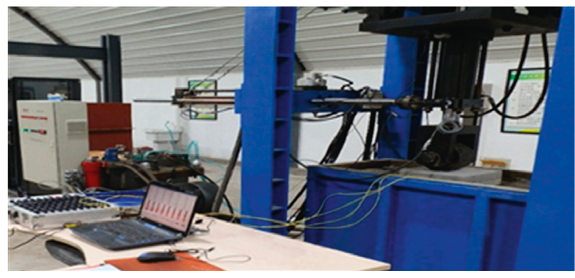
Figure 2: The ARSTS. Table 1: Cement concrete material consumption per cubic meter.